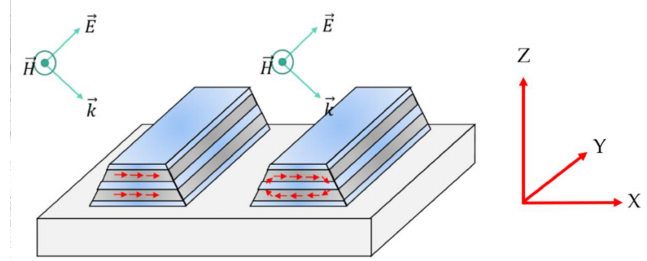
Figure 4. Representation of the actual trapezoidal shape of the grating due to fabrication limitations. A TM-polarized beam is incident at an incline; depending on frequency, either a symmetric ( Left ) or antisymmetric ( Right ) mode may be excited. Note that the strips are still considered to be infinite in the